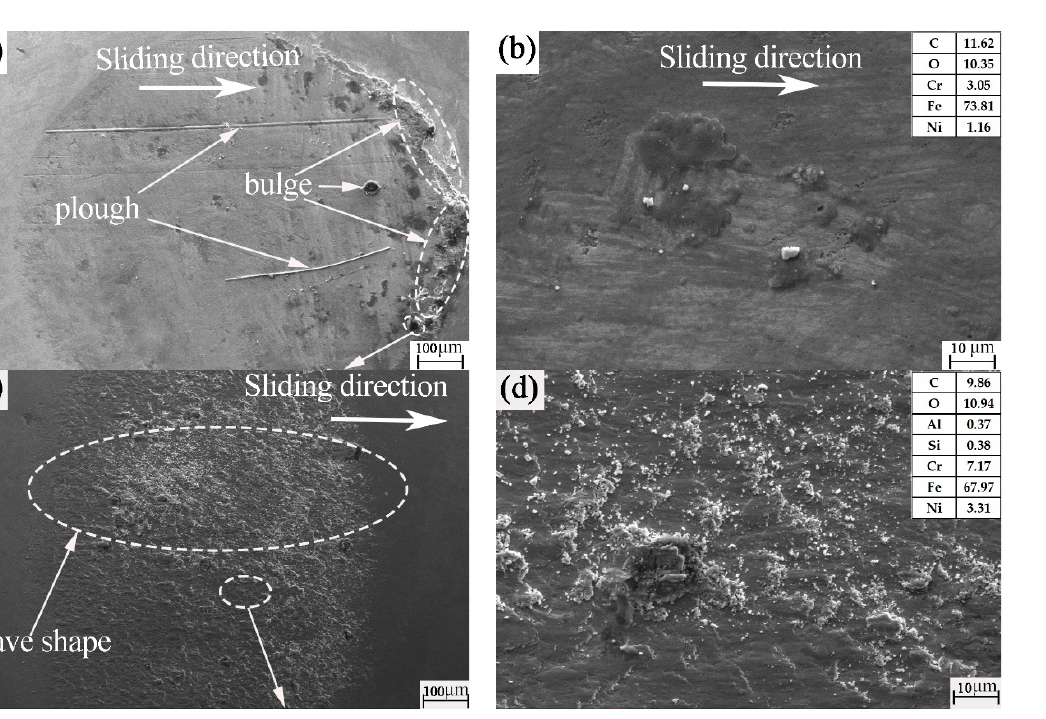
Figure 8. SEM images of the worn balls: ( a , b ) untextured friction radius 18 mm, and ( c , d ) 0.6 mm groove width mechanical texture friction radius 18 mm.